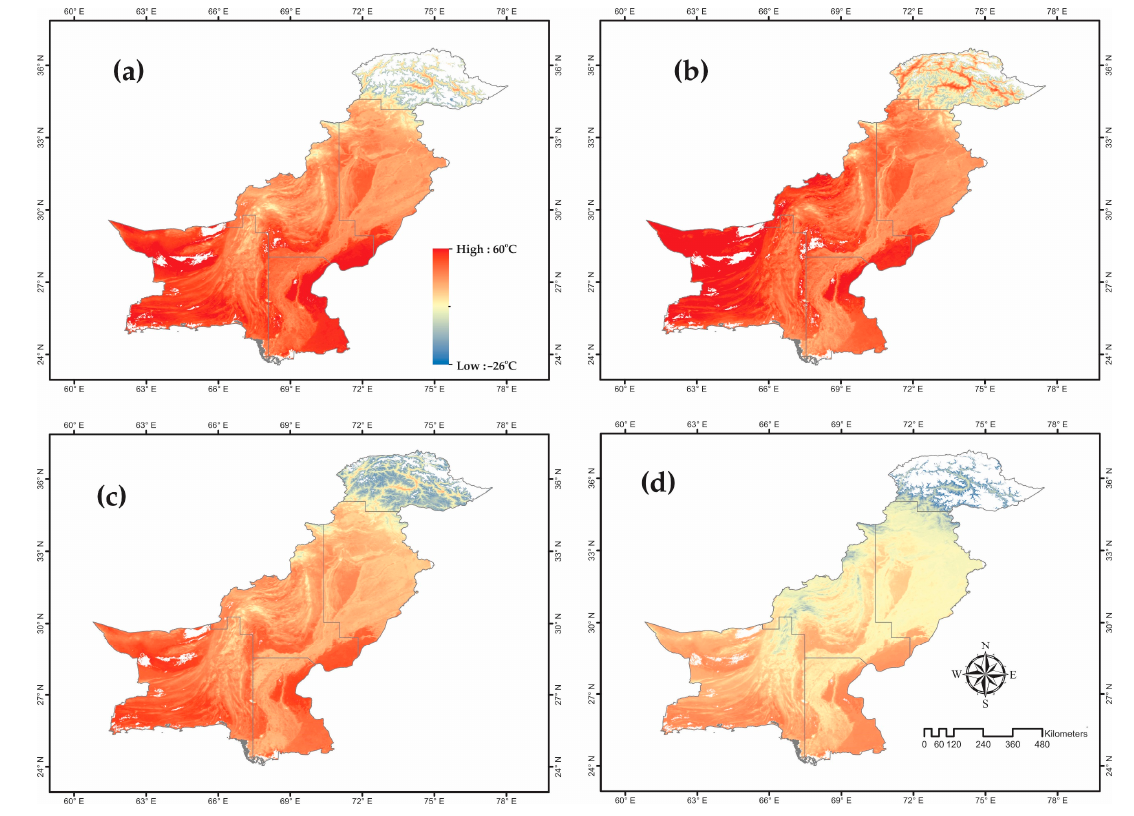
Figure 8. Spatial distribution of seasonal mean LSTs between 2018 and 2021 in Pakistan. ( a ) Spring, ( b ) summer, ( c ) winter, ( d ) autumn.